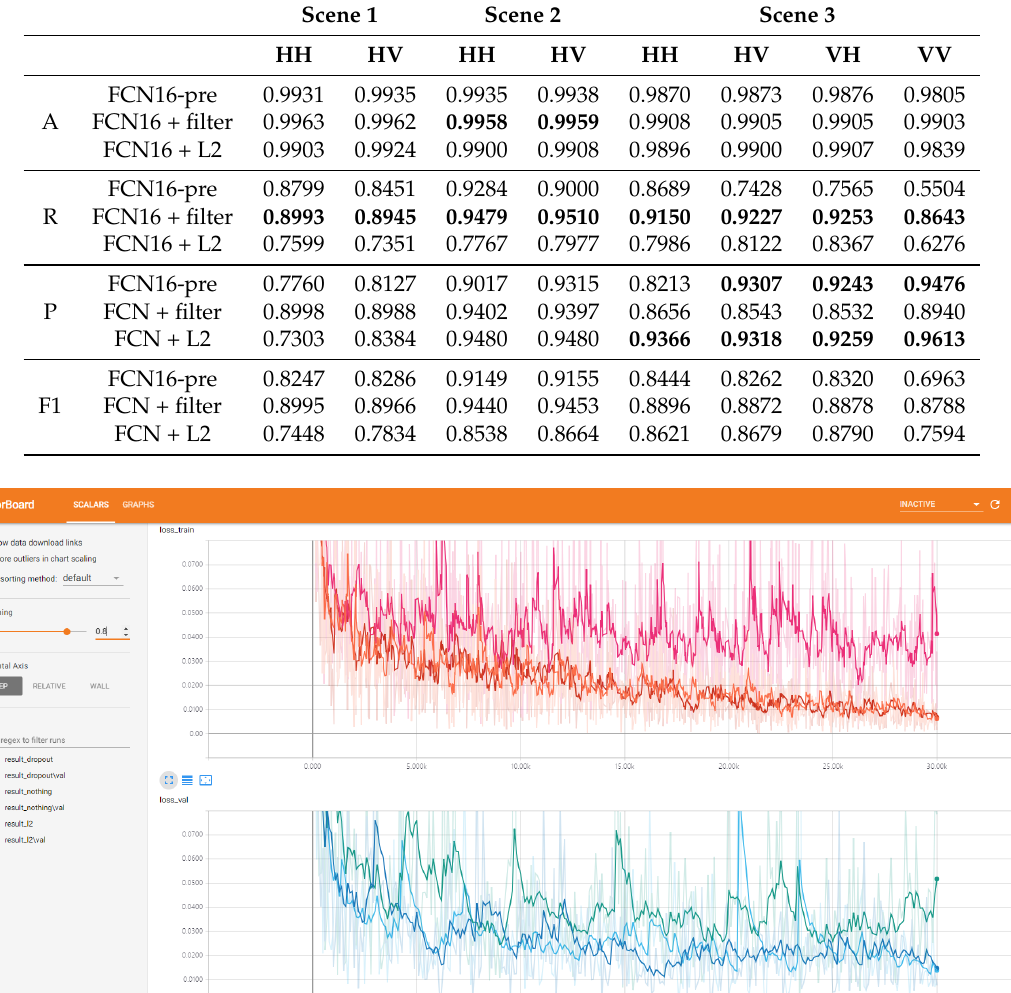
Table 7. The indices of different conditions. A is accuracy, R is recall, P is precision, F1 is F1 score, given in Equation (3). The results better than FCN16 are in bold.